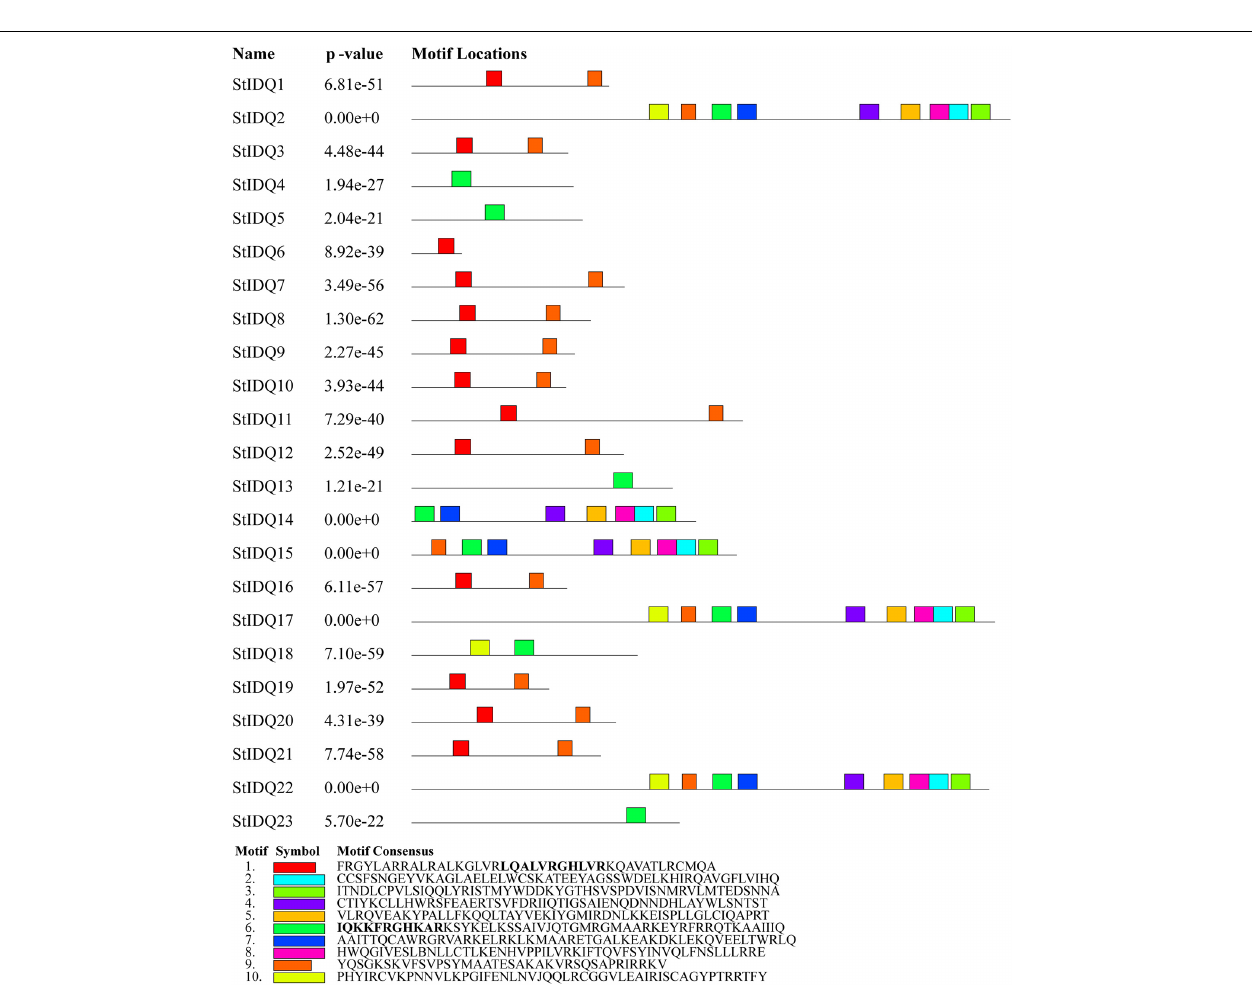
FIGURE 1 | The motifs in IQD proteins of Solanum tuberosum L. (StIQD). Each motif was represented by different colored box. The sequence of each motif is listed below with the same color.